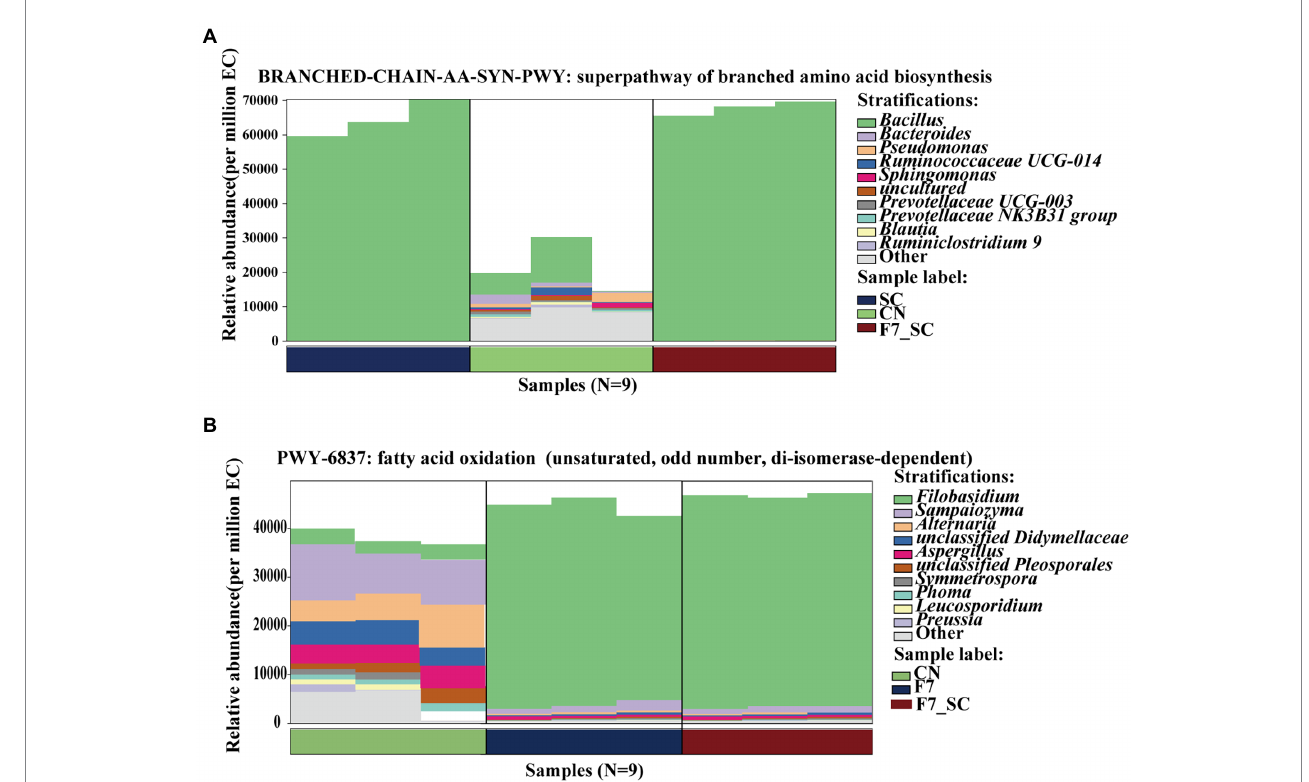
FIGURE 4 Maps of the genera composition in the differential MetaCyc metabolic pathway of bacterial (A) and fungal (B) consortia. CN represents the control group. SC represents B. kochii SC mono-culture. F7 represents F. magnum F7 mono-culture. F7-SC represents F. magnum F7- B. kochii SC co-